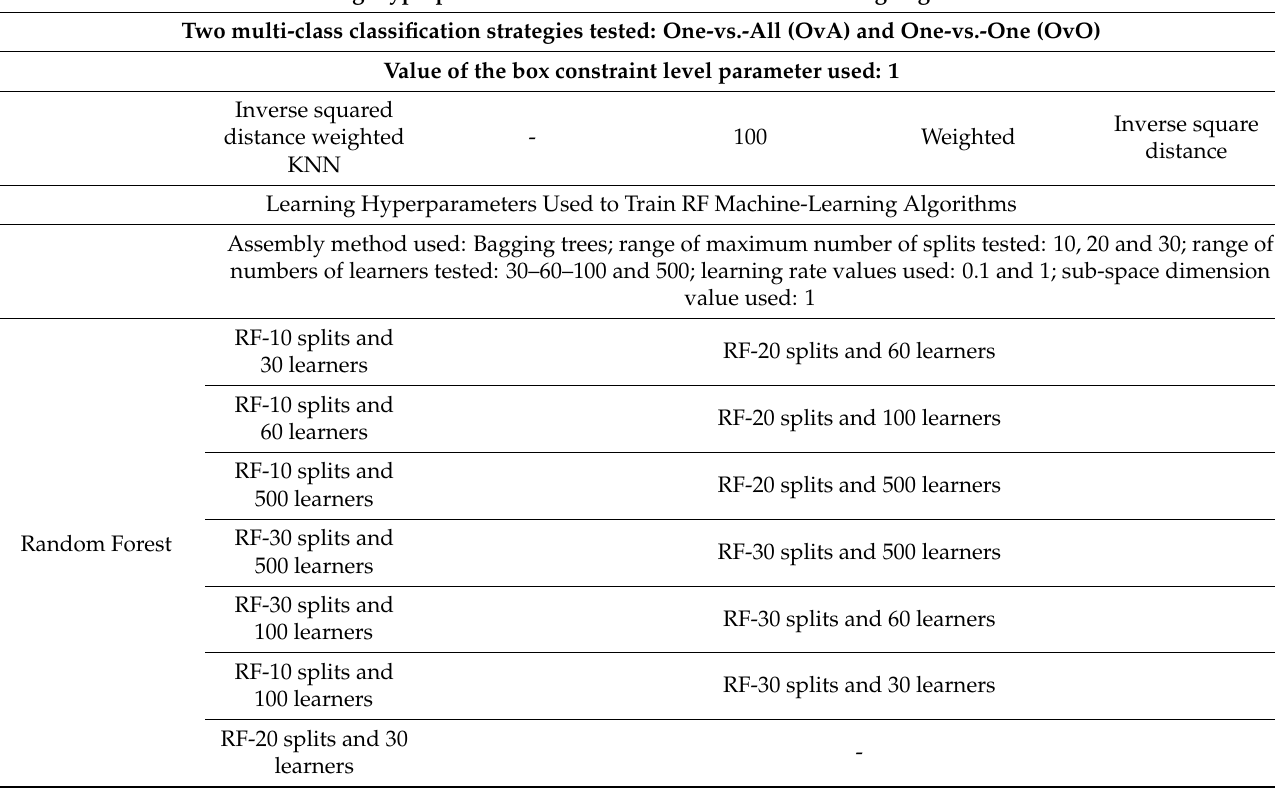
Table 3. Cont. Learning Hyperparameters to Train SVM Machine-Learning